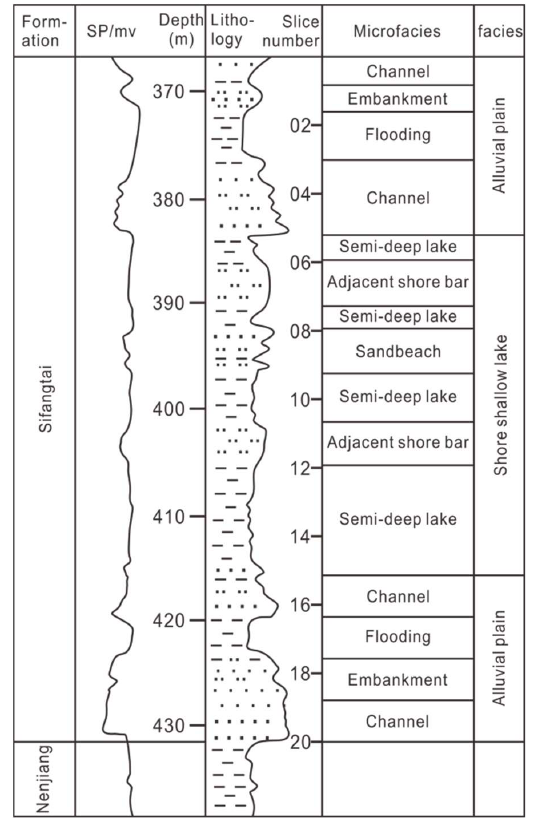
Figure 9. Sedimentary evolution in well 28. It is modified from Chen et al. in 2013 [41].